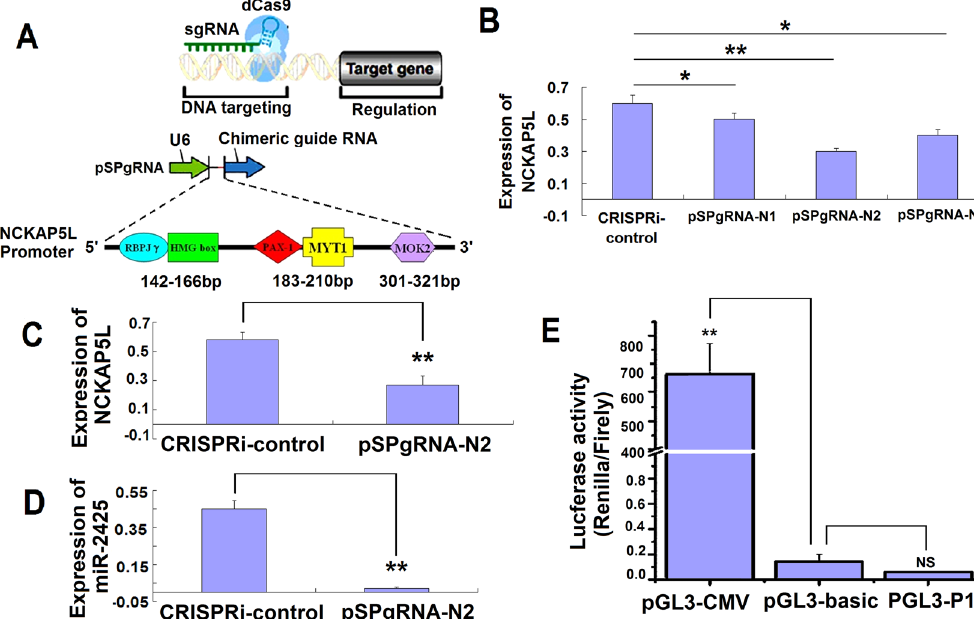
Figure 6. MiR-2425-5p is co-expressed with its host gene, NCKAP5L . ( A ) Three sgRNAs targeting sites within the NCKAP5L promoter. ( B ) NCKAP5L expressed in MDSCs after co-transfection of the CRISPRi system. pSPgRNA-N1, pSPgRNA-N2 and pSPgRNA-N3 that represented different inhibitory sequences were co-transfected into MDSCs with dCas9. ( C ) NCKAP5L expression after co-transfection with dCas9 and pSPgRNA-N2. ( D ) MiR-2425-5p expression after co-transfection with dCas9 and pSPgRNA-N2. ( E ) Luciferase activity of pGL3-P1 in MDSCs. * P < 0.05, ** P < 0.01, NS: no significant